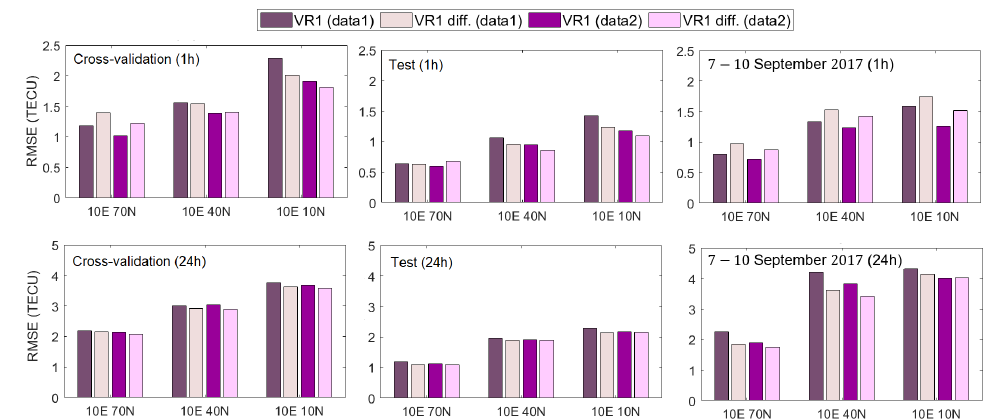
Figure 14. The RMSE for cross-validation ( left ), test ( mid ) and geomagnetic storm ( right ) datasets for 1 h ( top ) and 24 h ( bottom ) forecasts for the VR1 model. Models trained with differenced data are marked with “diff”. Data2 refers to data in Table 1, while Data1 comprises Data2 excluding inputs of EMA, VTEC (cid:48) and VTEC (cid:48)(cid:48) .